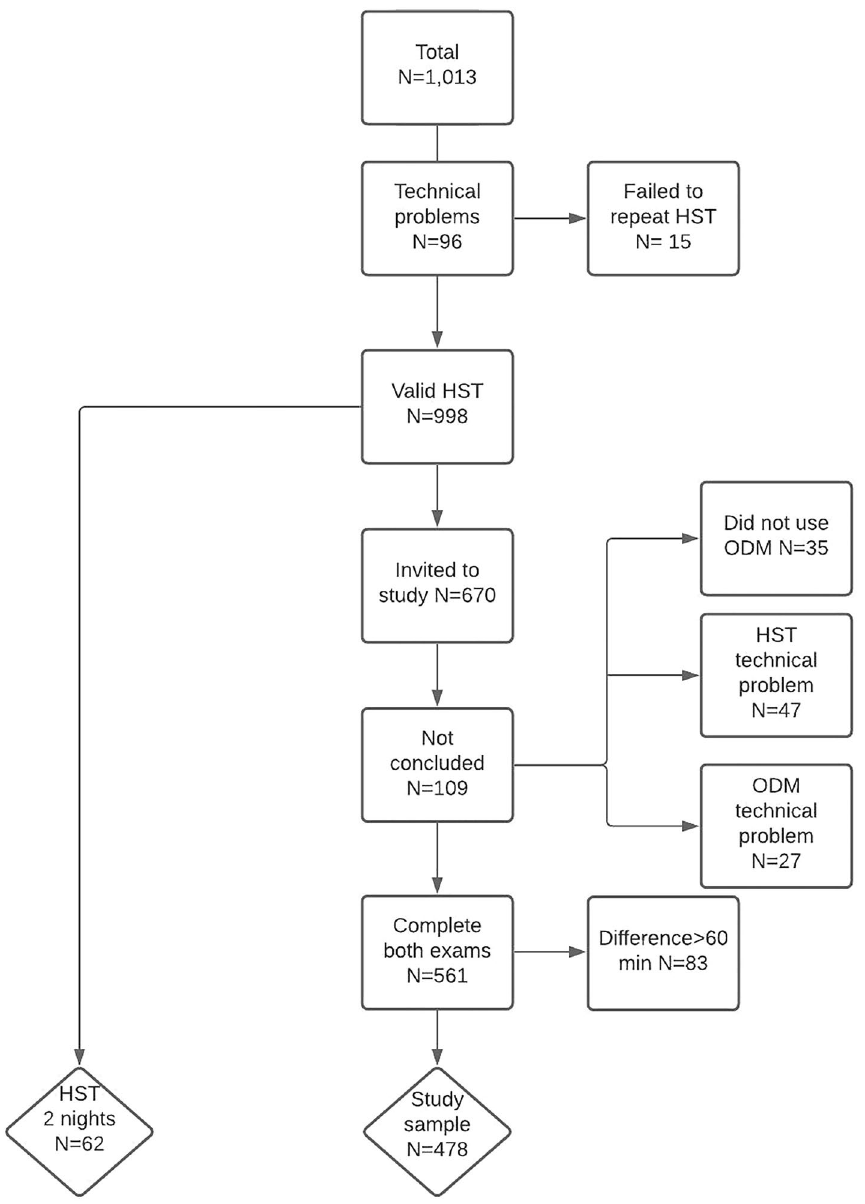
Figure 2. Participant flow diagram. N = number of